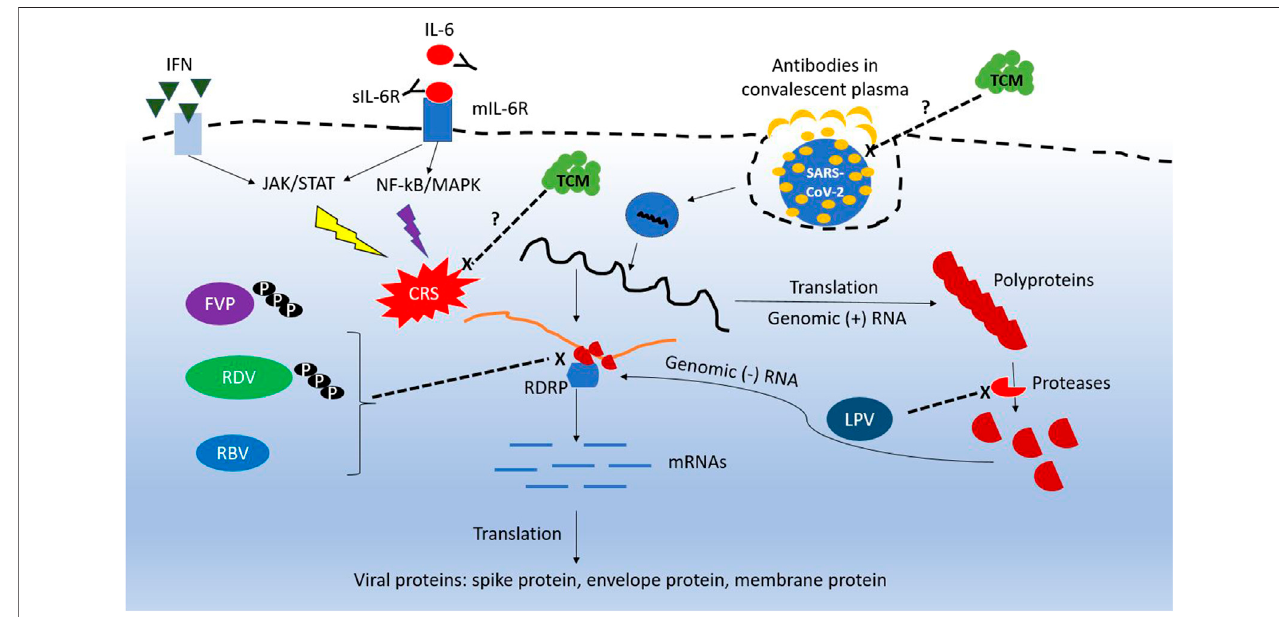
FIGURE 1 | Conceptual diagram of the mechanism for repurposing antiviral agents against SARS-CoV-2. RDV, remdesivir; FVP, favipiravir; RBV, ribavirin; IFN, interferon; sIL-6R, soluble IL-6 receptor; mIL-6R, membrane IL-6 receptor; TCM, traditional Chinese medicine.